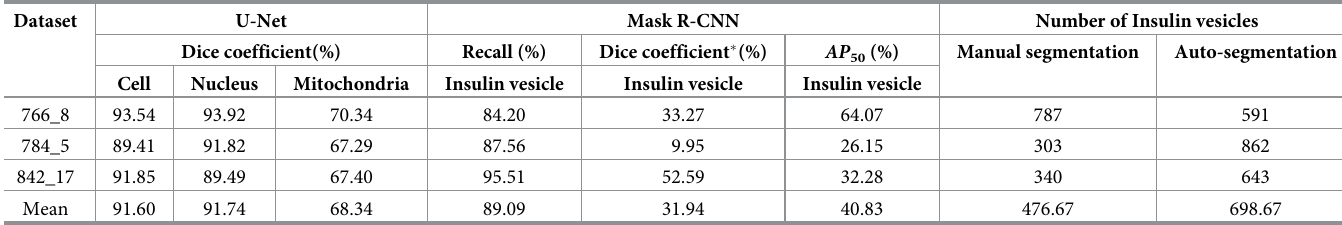
Table 1. Auto-segmentation accuracy: Dice, Recall, AP 50 , and insulin vesicle numbers on test datasets compared to manual segmentation [3].